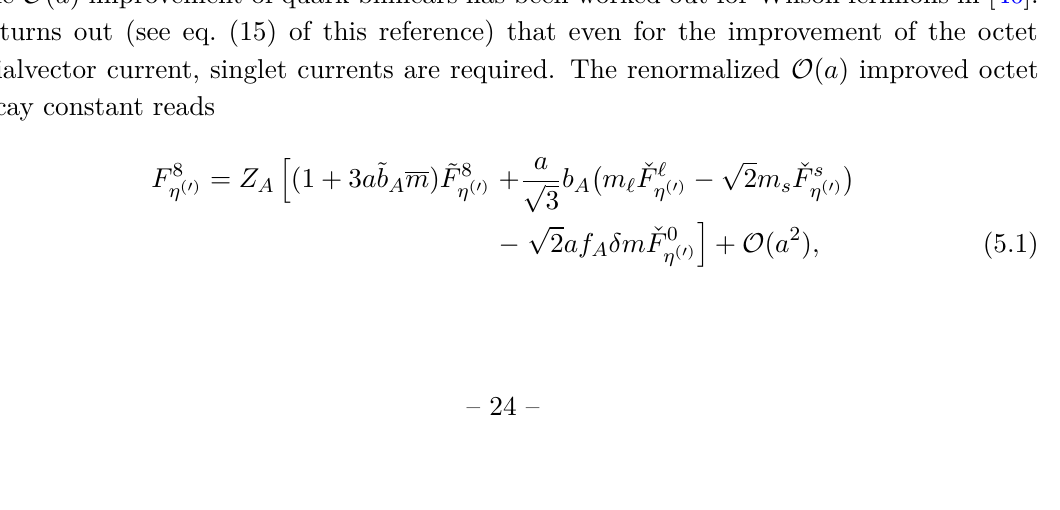
Table 5. Renormalized and partially improved octet and singlet decay constants of the η and η 0 mesons obtained from fits to eq. (4.27) in units of the gradient flow scale, the same ensemble). Ensembles H102a and H102b were generated with the same quark masses and lattice coupling but different simulation parameters and are therefore analysed